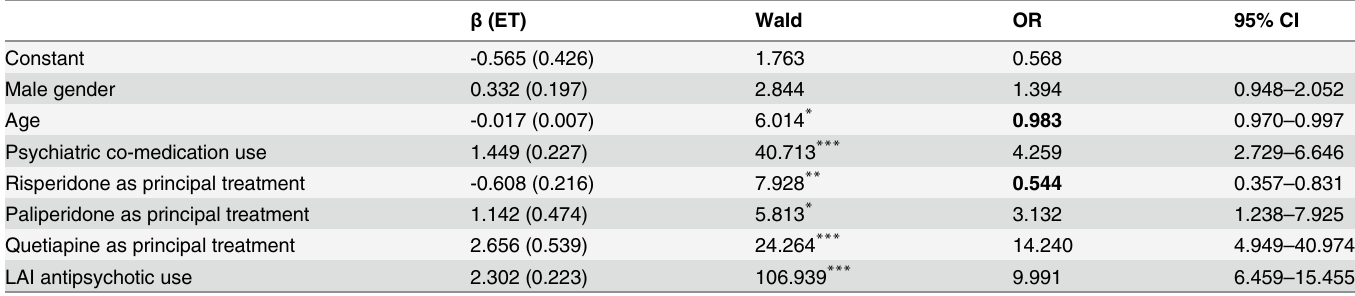
Table 4. Variables associated with antipsychotic polypharmacy in patients with schizophrenia. Multivariate exploratory model using backward step- wise logistic